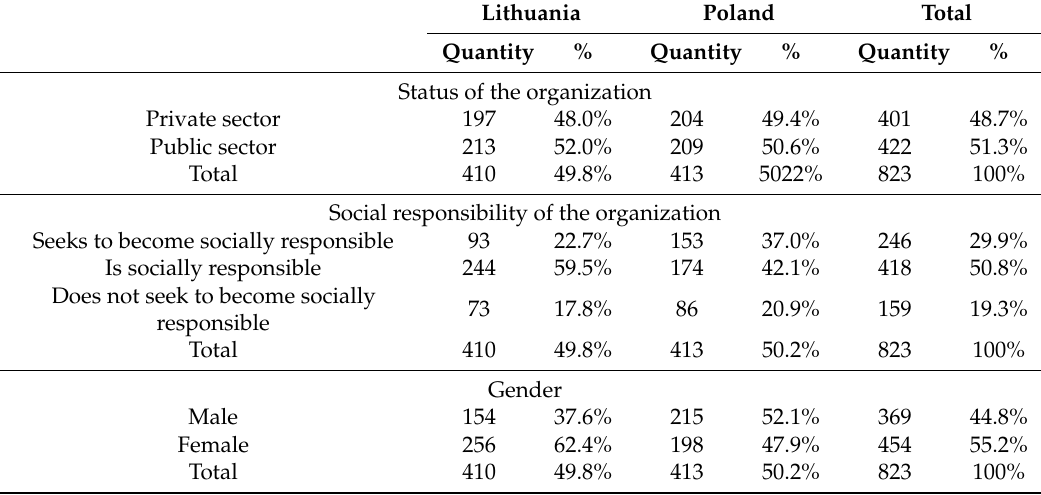
Table 2. Characteristics of the research